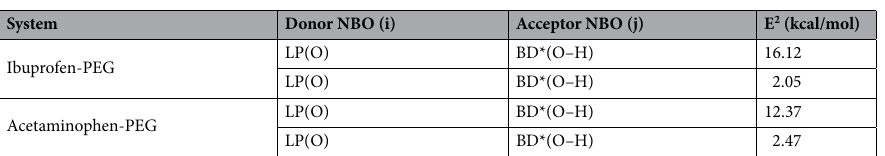
Table 6. The donor–acceptor NBO interactions and second order perturbation energies (E 2 ) for binary systems containing drugs and PEG.